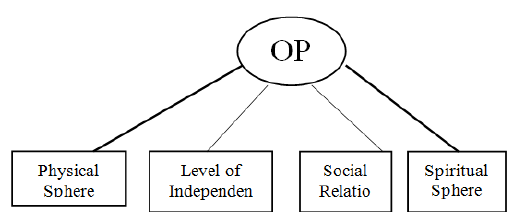
Figure 2. Correlation relationships of the indicator “OP” of the teachers’ group 1 Note: correlation at a significance level of 0.05. correlation at a significance level of 0.01.